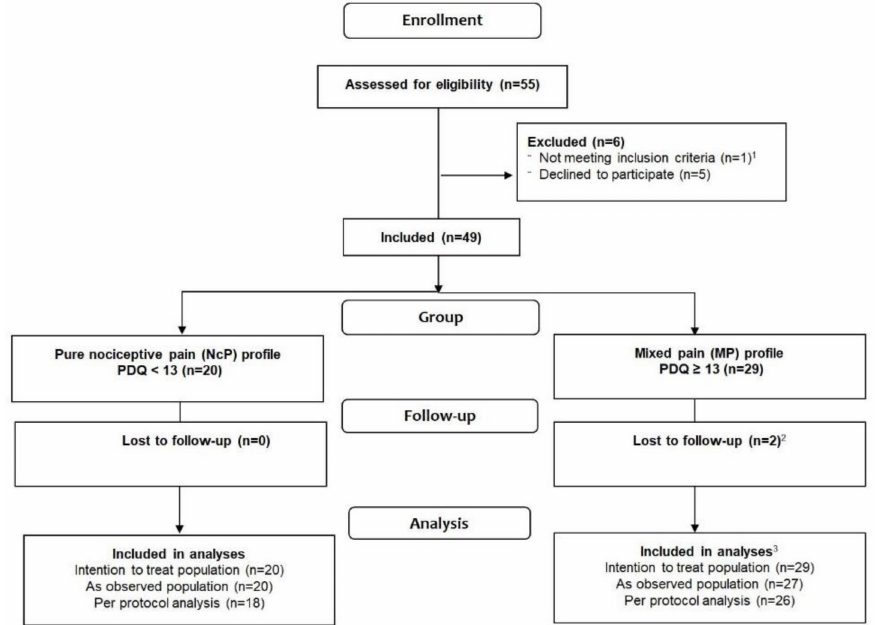
Figure 1. Flow chart. 1 Did not fulfill axSpA classification criteria. 2 Reasons for drop out: one participant moved to another hospital, and one participant was hospitalized. 3 As observed refers to participants with available data for analyses and per protocol to participants with available data for analyses and adherence to the prespecified